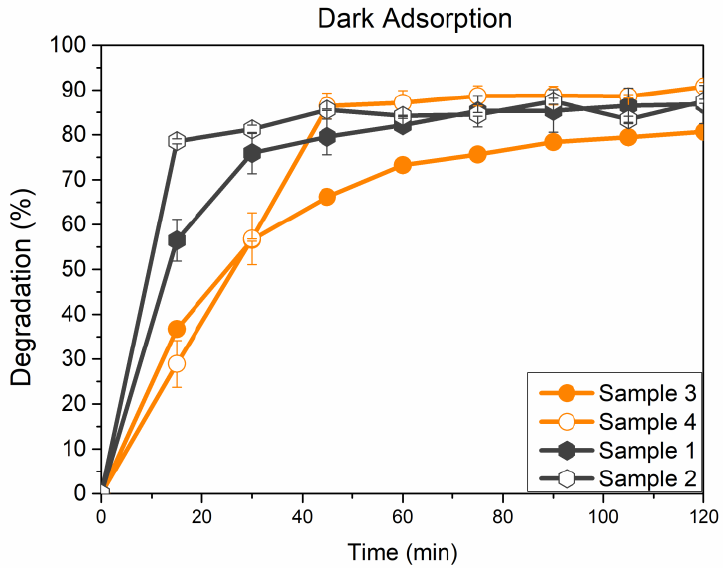
Figure 5. MO percentage degradation (calculated according to Equation (1)) for investigated samples in dark condition.